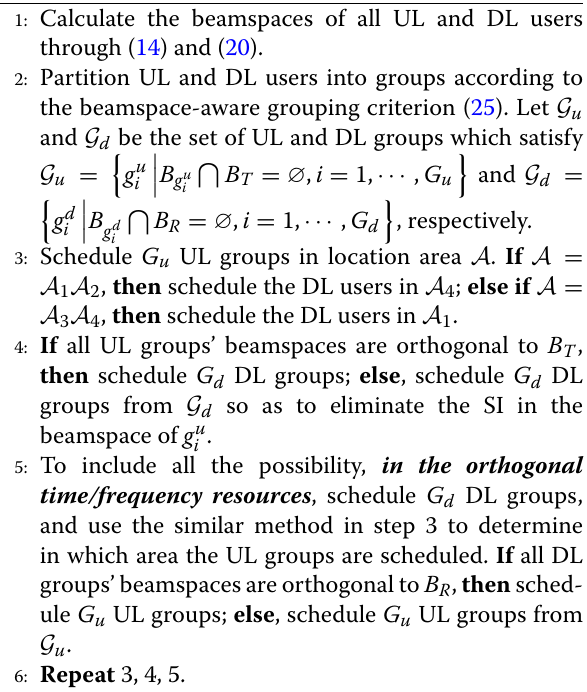
Algorithm 1 User Scheduling Based on the Distance and SI Beamspaces Isolation